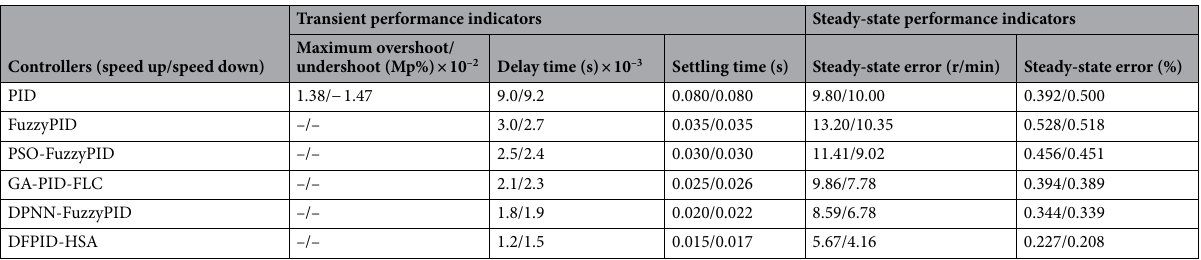
Table 10. The comparison of performance indicators under the speed changes